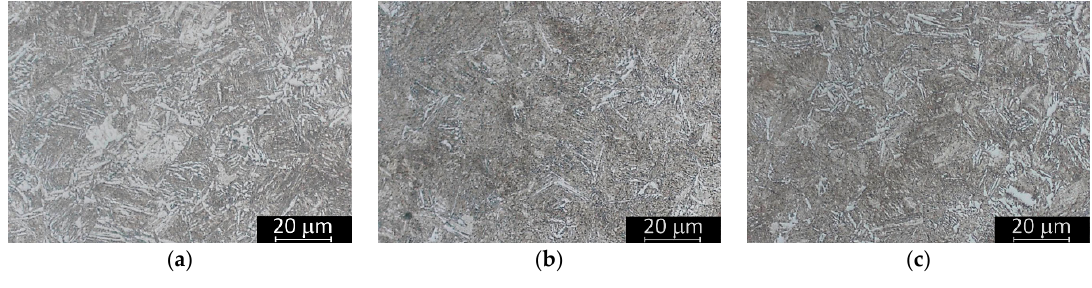
Figure 2. Etched microsections for the alloys ( a ) S76; ( b ) S110; ( c ) S280.